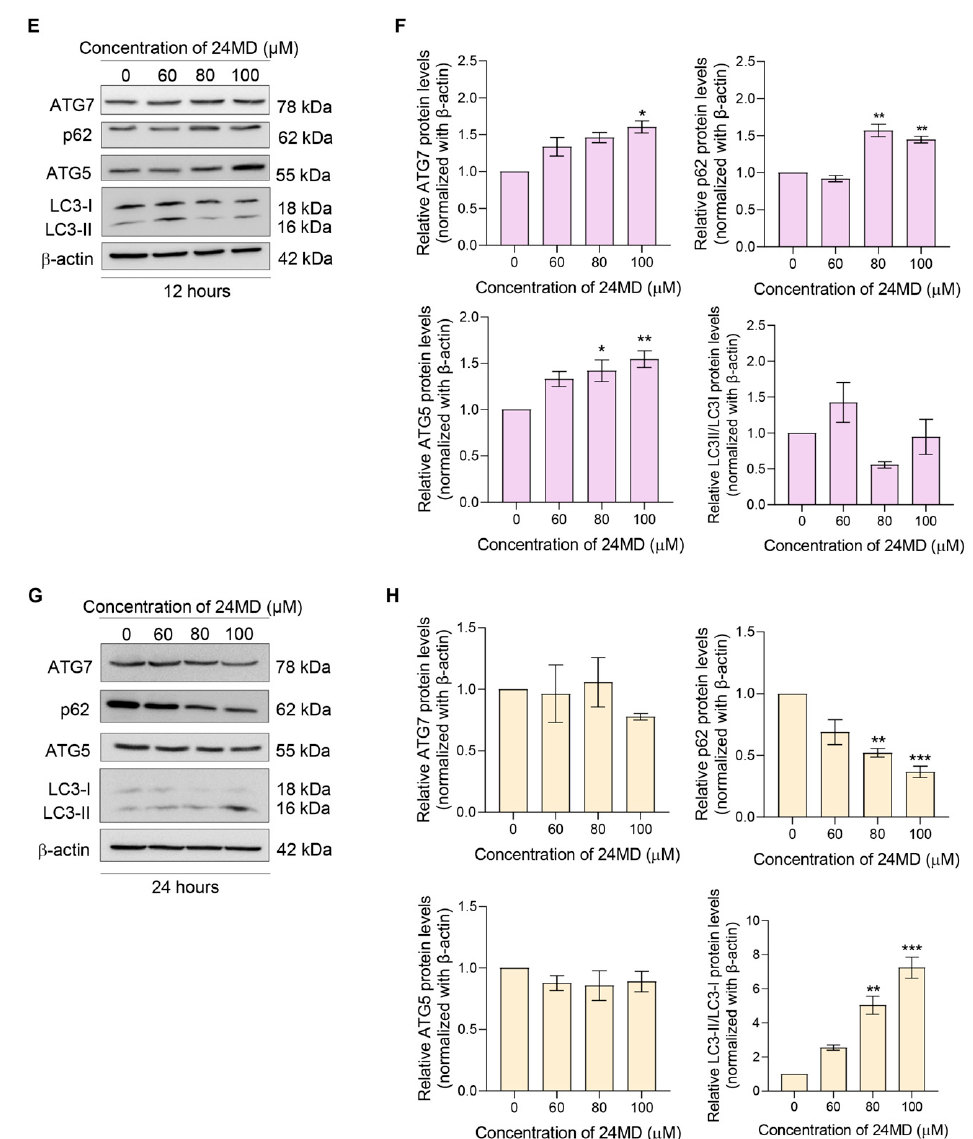
Figure 2. Effect of 24MD on autophagy induction and autophagic flux in A549 cells. ( A , B ) A549 cells were treated with 24MD (0–100 µ M) for 24 h. The morphological changes of the A549 cells were visualized under a phase contrast microscope, and the number of vacuoles per cells were calculated. ( C , D ) A549 cells were stained with MDC after treatment with various concentrations of 24MD (0–100 µ M) for 24 h and visualized under a fluorescence microscope. The green fluorescence of MDC represented the autophagic vacuole. The fluorescence intensity was measured, and the relative mean intensity was calculated. ( E – H ) Western blot analysis was performed to assess the autophagic markers, ATG5, ATG7, p62 and LC3B after 24MD treatment for 12 h and 24 h in A549 cells. β -actin protein was measured to confirm equal loading in each sample. The densitometry of each protein levels was calculated, and the results were demonstrated in relative protein levels. Data represent the mean ± SEM ( n = 3) (* 0.01 ≤ p < 0.05, ** 0.001 ≤ p < 0.01 and *** p < 0.001 when compared with non-treatment